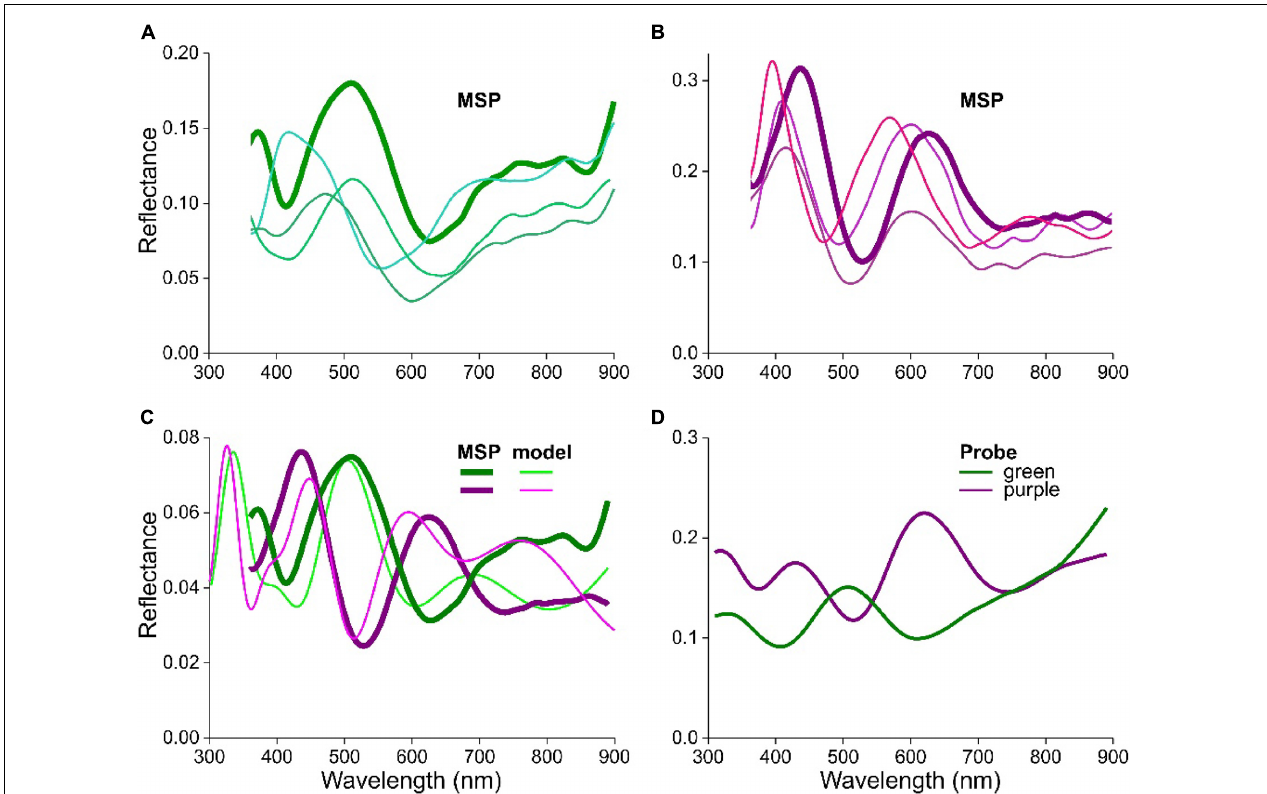
FIGURE 4 | Reflectance spectra of feathers and barbules of S. vulgaris . (A) Spectra from local areas of a green breast barbule measured with a microspectrophotometer (MSP). (B) Spectra from local areas of a purple throat barbule measured with the MSP. (C) The bold MSP spectra of (A,B) compared with modeled (model) spectra for cortex thicknesses of 300 nm (green) and 390 nm (purple). (D) Reflectance spectra measured with a bifurcated reflection probe of a green and purple wing area.